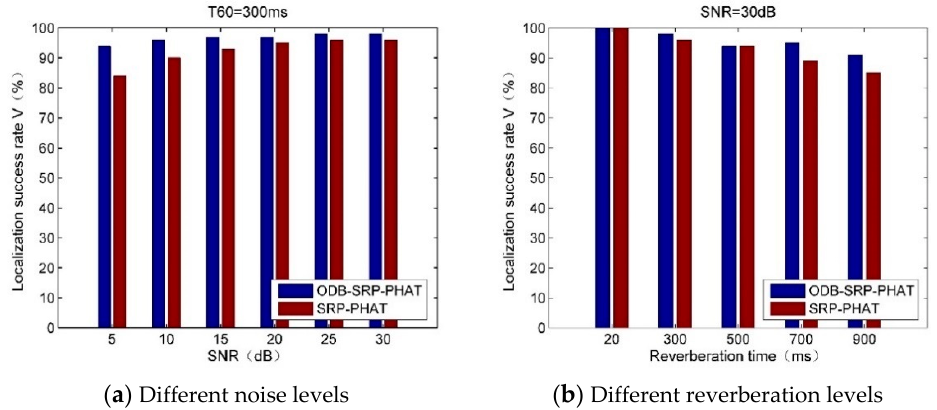
Figure 7. Comparison of the localization results under different noise and reverberation condi- tions.